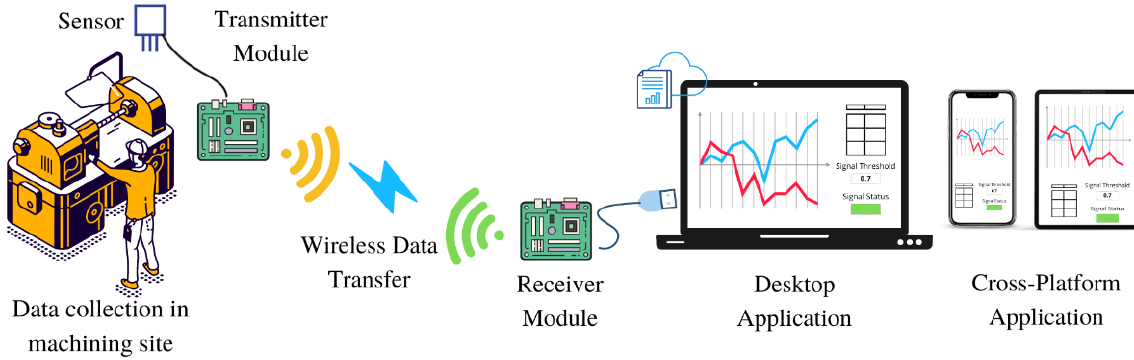
Figure 1. Overall system architecture.